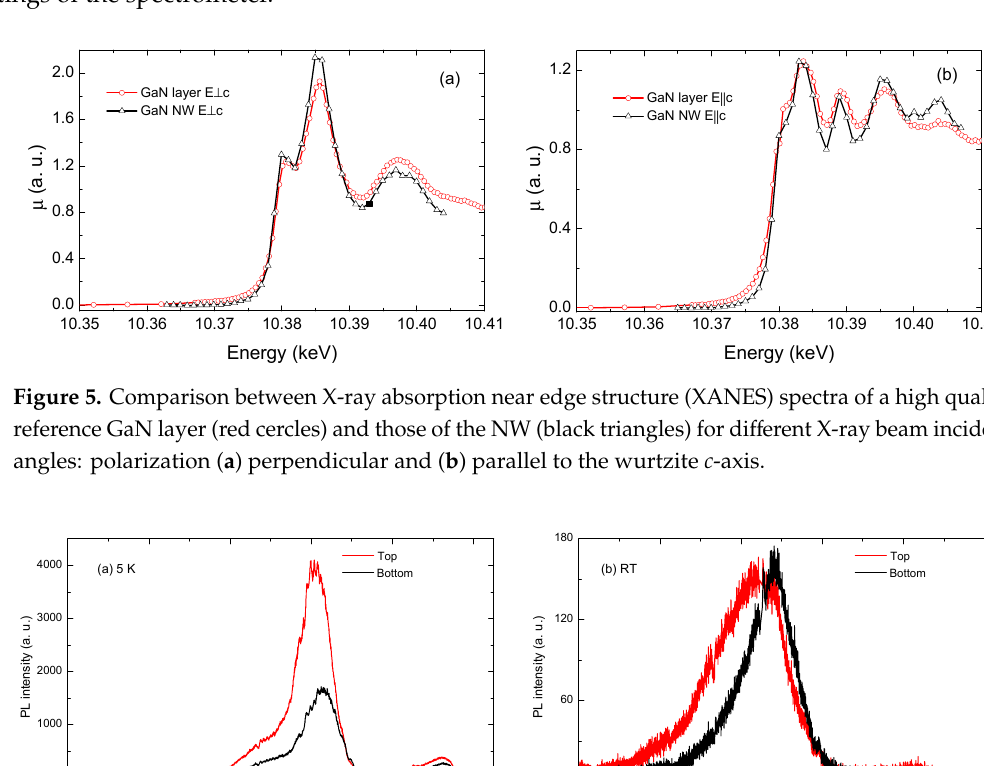
Figure 5. Comparison between X-ray absorption near edge structure (XANES) spectra of a high quality reference GaN layer (red cercles) and those of the NW (black triangles) for different X-ray beam incident angles: polarization ( a ) perpendicular and ( b ) parallel to the wurtzite c -axis.